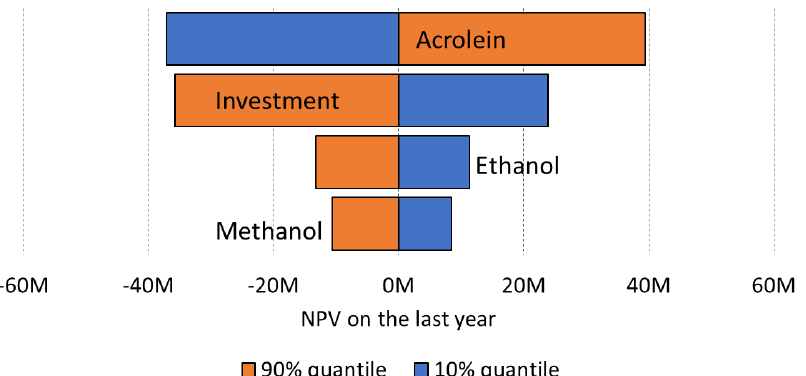
Figure 21. Tornado plot for a big plant (50,000 tons/year) at 70% yield with 30% subsidies on capital cost. For capital cost, we used a −20/+ 30% distribution on the median CAPEX corresponding to probability range of P24 and P68, respectively, and a Class 3 confidence.